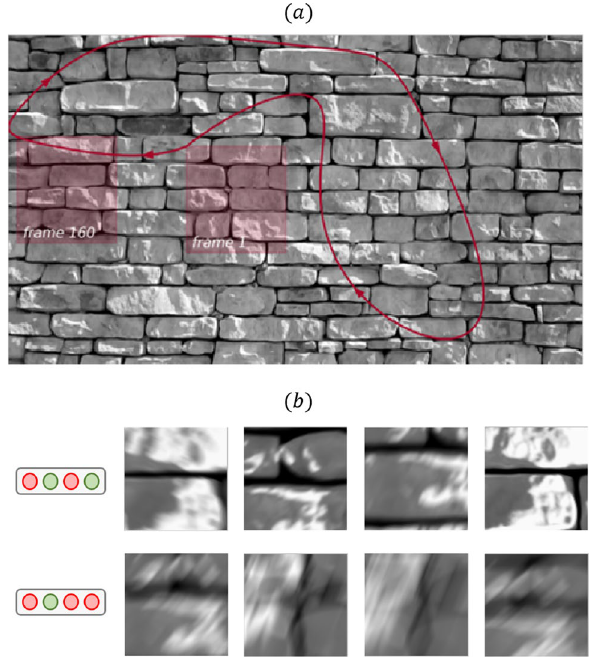
Figure 4. Results related to Experiment 3. Panel ( a ) shows the trajectory followed to show natural scene stimuli to the retina during Experiment 3. Panel ( b ) shows visual features encoded by different binary states (top) and binary units (bottom). While visual features extracted via hidden states and units appear more similar than what we could observe, e.g., in Fig. 2, it can still be observed that units reflect more generic visual features (they are more blurred, because they aggregate more